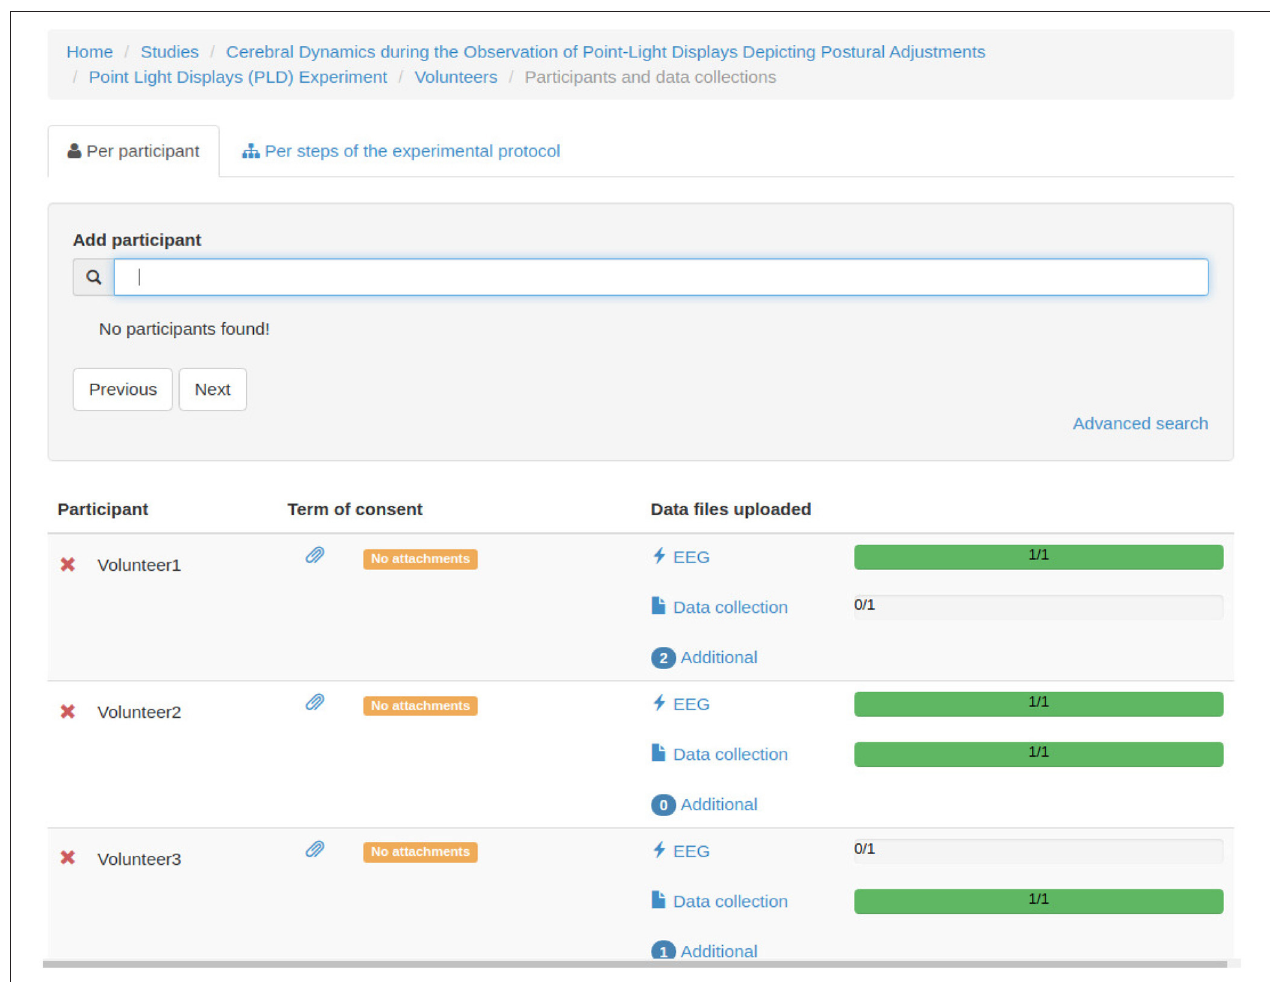
FIGURE 10 | NES graphical interface for listing participants and data collections of an